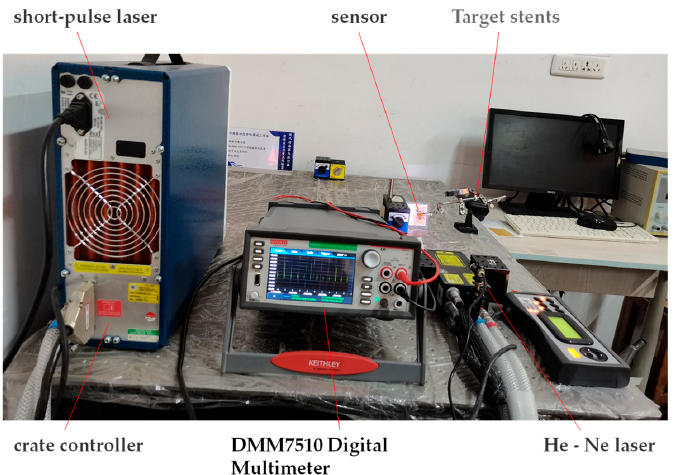
Figure 13. A thin film thermocouple temperature sensor dynamic calibration system. We connect the compensation wire of the film thermocouple temperature sensor to the DMM7510 Digital Multimeter and set the sampling rate, storage, and other parameters. The temperature sensor is fixed to the target frame of the test stand. The red-light source of the HE-Ne laser is adjusted to focus on the hot contact position of the thin-film thermocouple temperature sensor. We change the laser source to correspond to the laser red light source and then adjust the laser voltage to 640 V and the laser energy to 18.25 MJ and choose the automatic emission mode to the output laser pulse. Finally, the DMM7510 Digital Multimeter displays and stores the dynamic calibration curve in real-time. The pulse response curve of the thermocouple temperature sensor is shown in Figure 14.